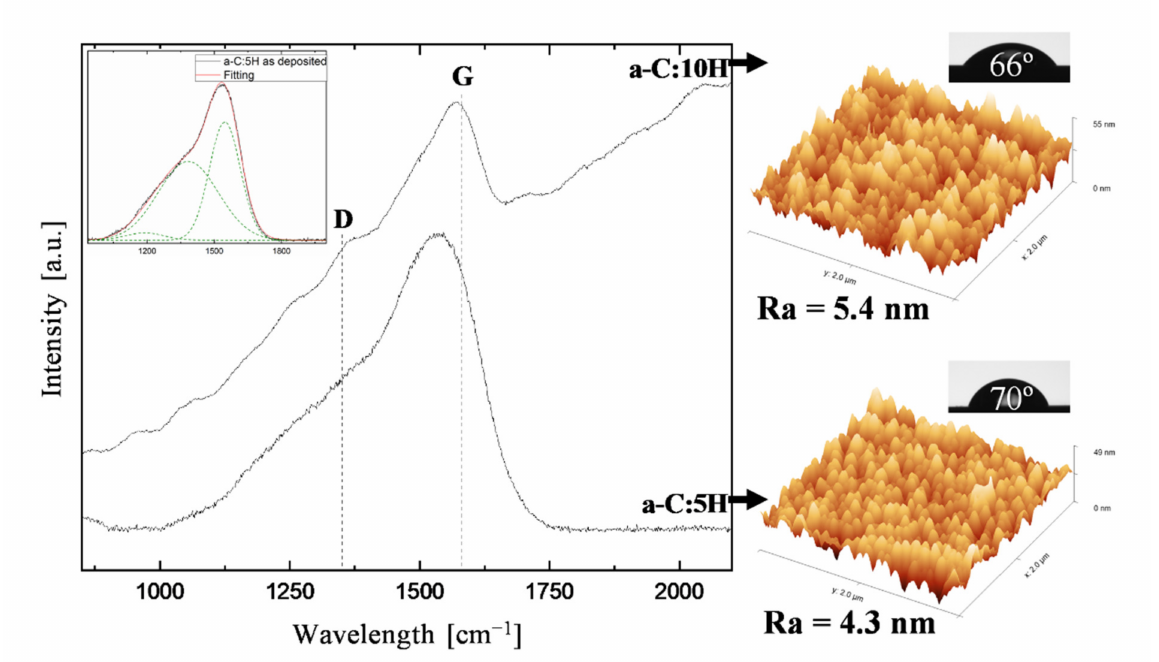
Figure 2. Visible Raman spectra of the as-deposited a-C:H coatings (inset: Gaussian fitting procedure for a-C:5H films), and the corresponding AFM surface topography and drop contact